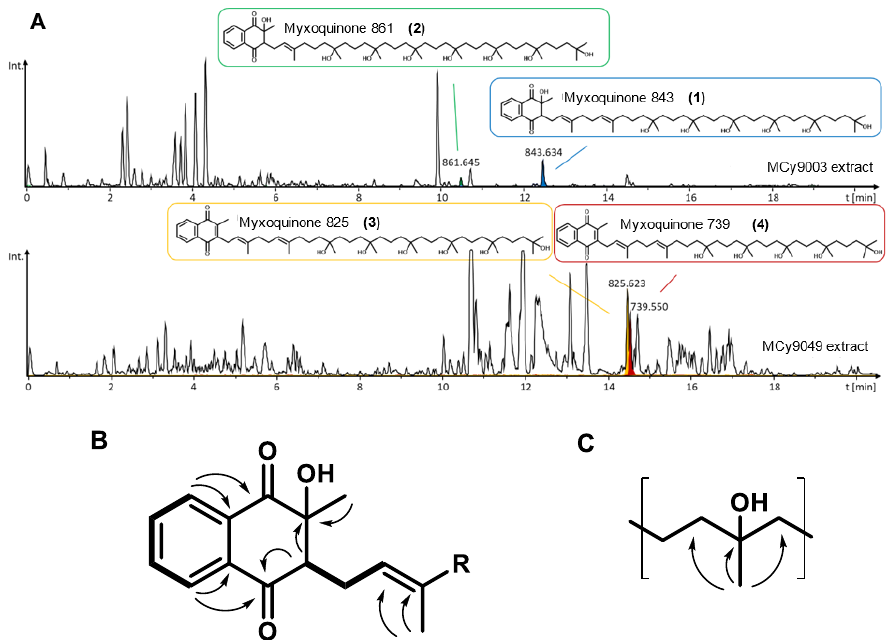
Figure 4. ( A ) LC- hr MS chromatograms showing production of the four myxoquinone derivatives by the respective myxobacterial strains. ( B ) Key COSY correlations (bold lines) and HMBC correlation (arrows) of the hydroxylated naphthoquinone system, and of the hydroxylated prenyl unit ( C ).